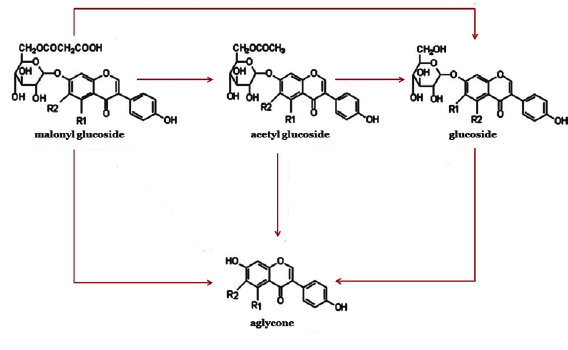
Figure 2: The most common occurred isoflavonoid glycosides decomposition